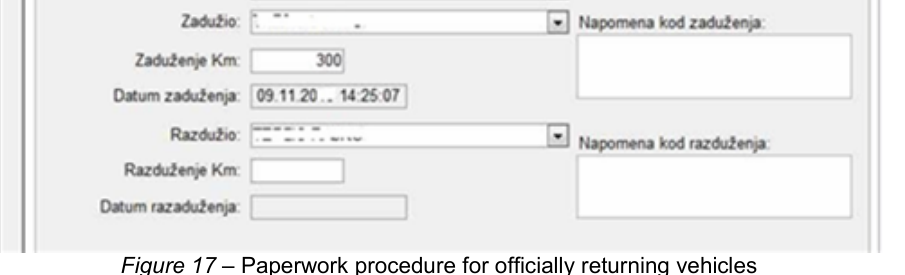
Figure 17 – Paperwork procedure for officially returning vehicles Рис . 17 – Процедура закрытия путевых